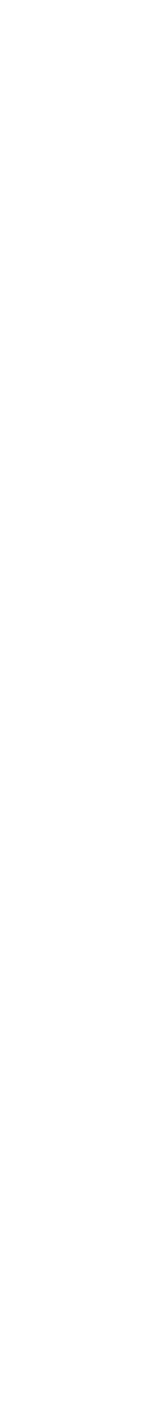
(Fig. 2; Linear regression, Serum Iron: F 1,29 = 25.3, P <